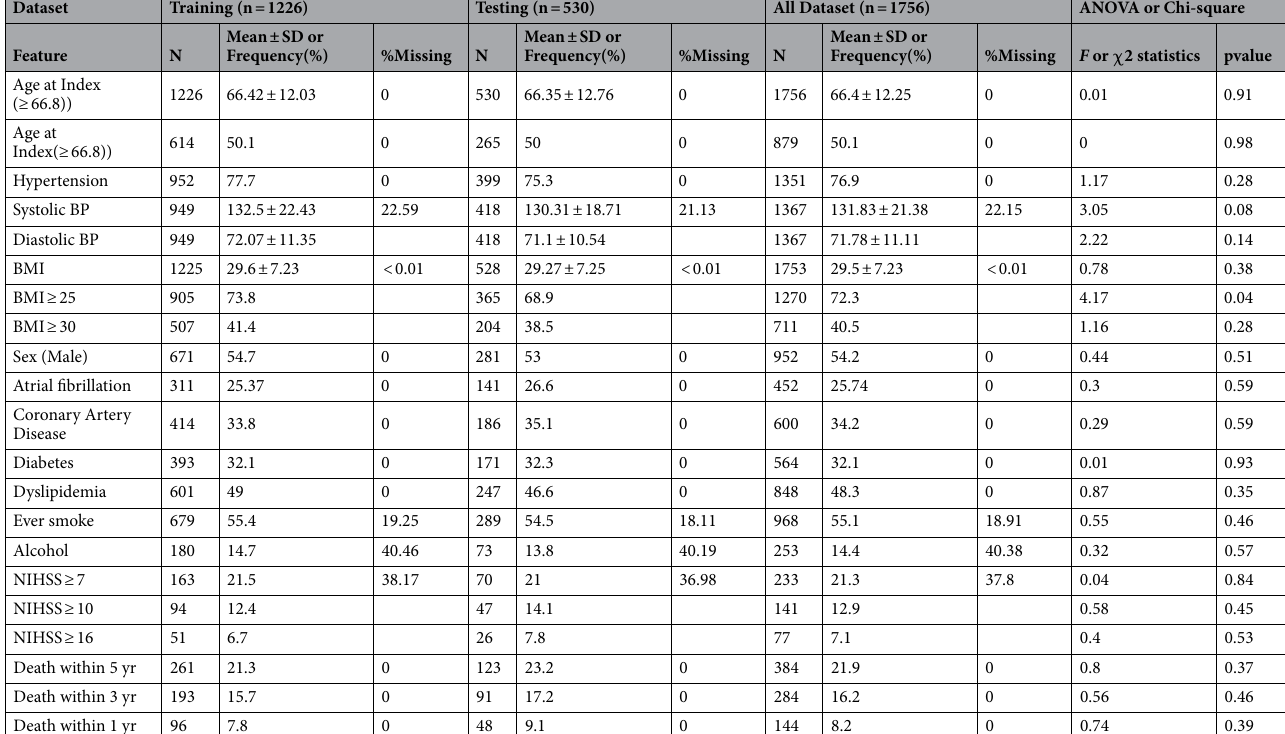
Table 1. Baseline characteristics in the retrospective study cohort. The study cohort was split into training and testing datasets. We also provided clinical characteristics stratified by dichotomized age at index stroke in eTable 2. ANOVA or Chi-square test was selected for quantitative or qualitative measures, respectively. Abbreviations; ANOVA = analysis of variance; BMI = body mass index; BP = blood pressure; Ever Ssmoke: Defined as ever smoke at least one cigarette per day within the three years prior to the event; Alcohol: Defined as consuming more than 200 g of pure alcohol per week. All continuous variables are reported as means with standard deviations, and dichotomous variables are reported as percentages. Patients with a BMI of 18.5 to 24.9 kg/m2 and BMI of 25 to 29.9 kg/m2 were categorized as normal weight and overweight, respectively. Patients with a BMI of 30 kg/m 2 and above were categorized as obese. NIHSS ≥ 7 was dichotomized NIHSS by score ≥ 7. Similar for NIHSS ≥ 10 and NIHSS ≥